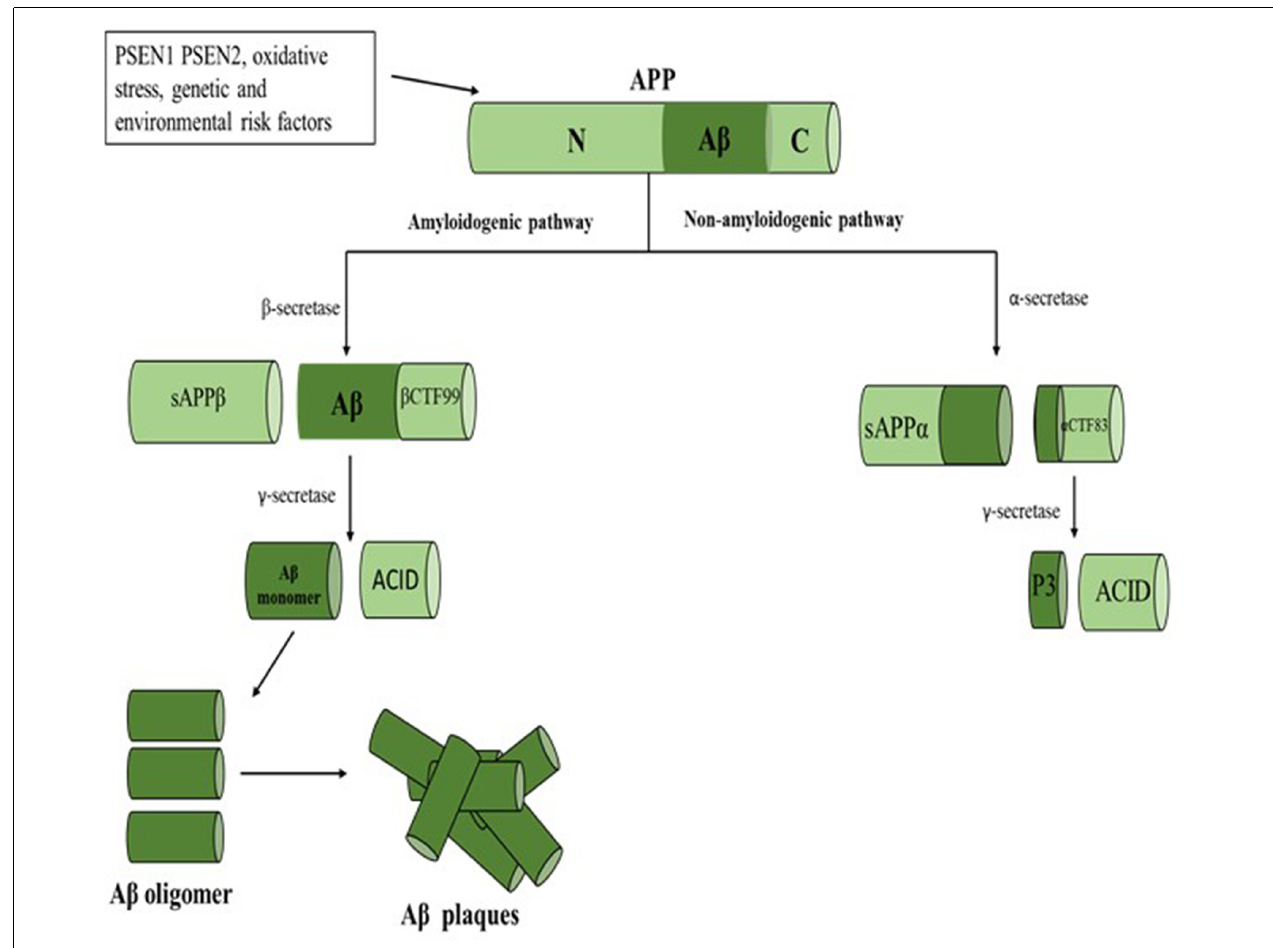
FIGURE 2 | Schematic of A β hypothesis. APP is sequentially cleaved via amyloidogenic or non-amyloidogenic pathways. In the non-amyloidogenic pathway, it is cleaved by α -secretase, resulting in the production of the sAPP α . In the amyloidogenic pathway, APP is initially cleaved by β -secretase, then γ -secretase, resulting in the production of A β peptides. Abbreviations: APP, amyloid precursor protein; PSEN1 , presenilin 1; PSEN2 , presenilin 2; A β , amyloid